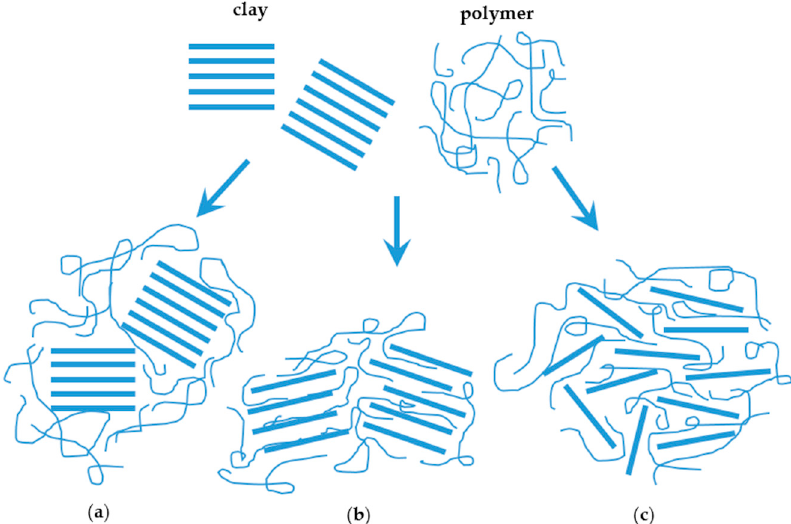
Figure 2. Scheme of different types of composite arising from the interaction of clays and polymers: ( a ) phase separated microcomposite; ( b ) intercalated nanocomposite; and ( c ) exfoliated nanocomposites. Adapted from [26].